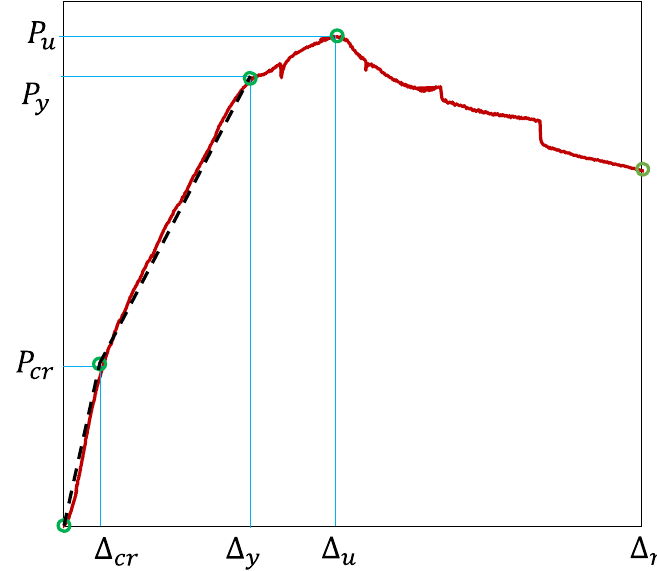
Figure 8. Definition of elastic, yield, and ultimate phases.